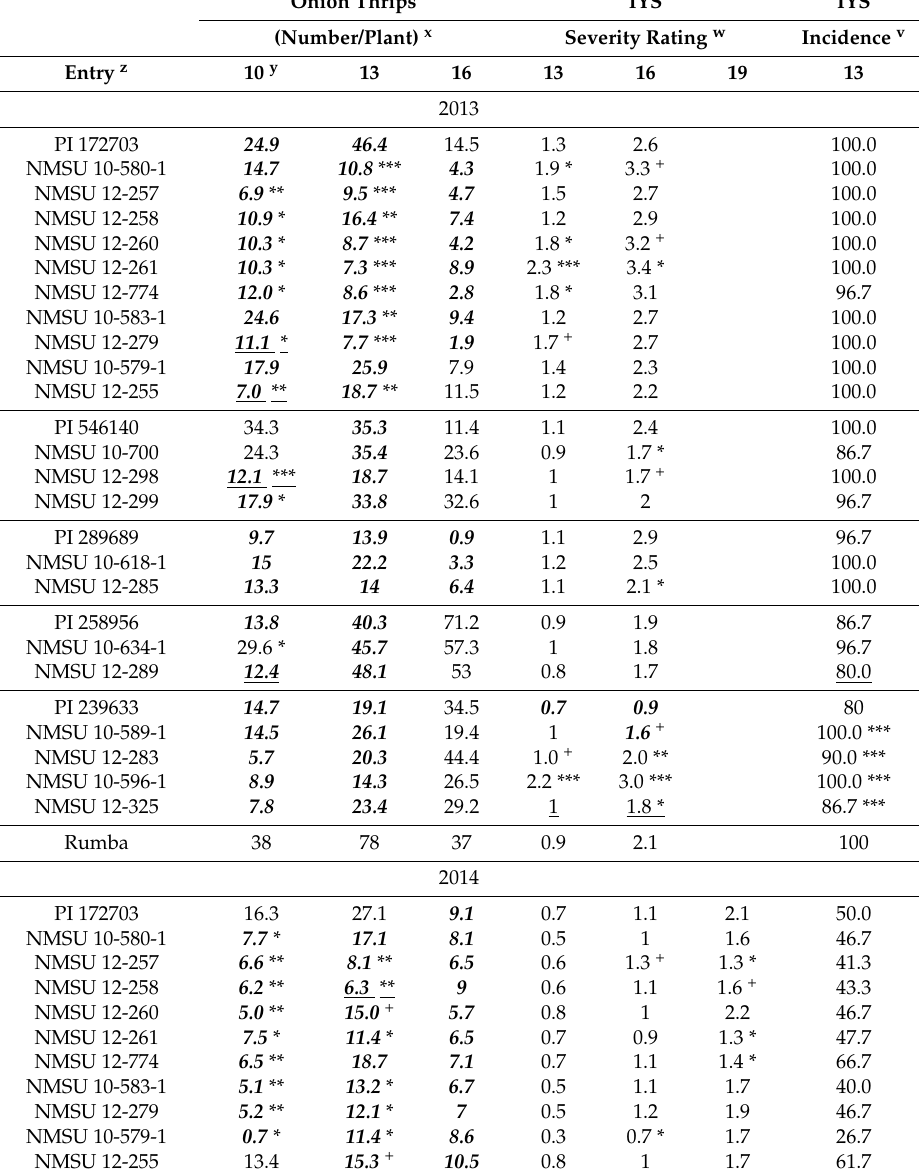
Table 1. Average number of onion thrips per plant, Iris yellow spot (IYS) severity rating, and IYS incidence for entries measured at several time intervals throughout 2013 and 2014 growing seasons at the Leyendecker Plant Science Research Center, Las Cruces,